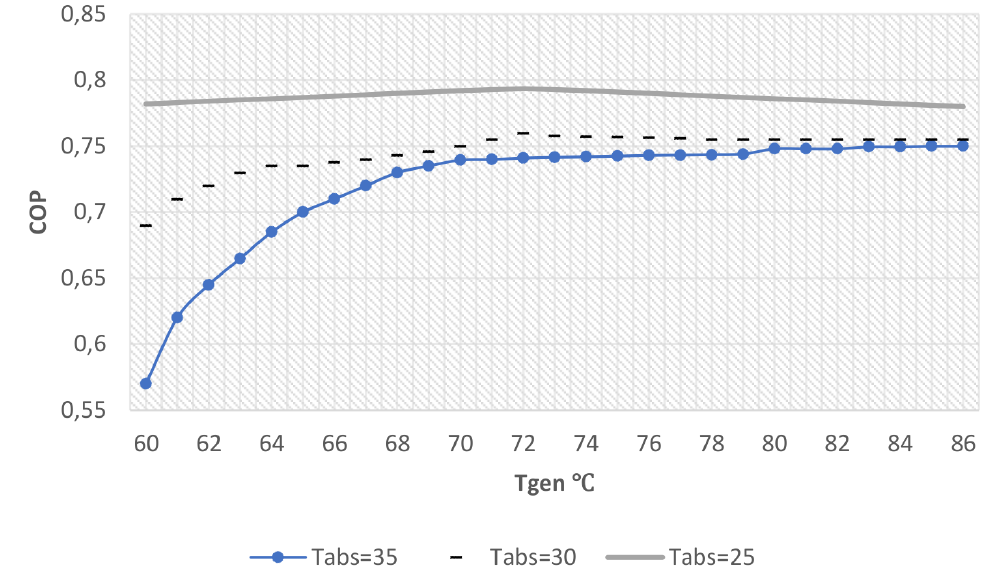
Figure 2. COP of the absorption cycle depending on the generator temperature, accounting for various absorber temperatures [9].